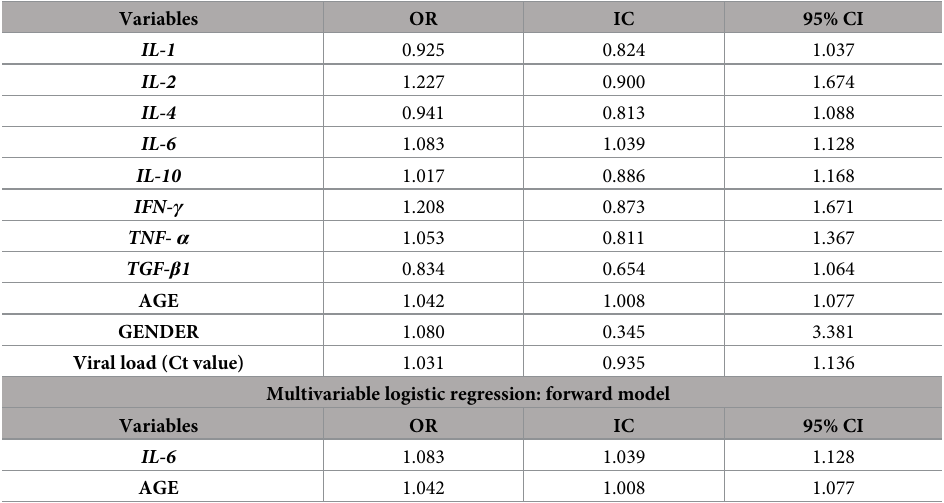
Table 3. A multivariable logistic regression model including all variables. The table shows the odds ratio (OR), information coefficient (IC), and 95% confidence interval (CI). Multivariable logistic regression: forward model, for only significant variables in the full analysis, is shown in the bottom